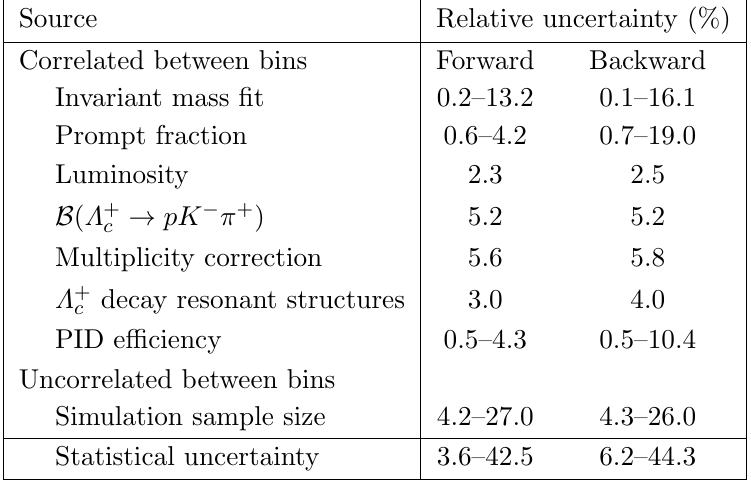
Table 1 . Systematic and statistical uncertainties for the di(cid:11)erential cross-sections. The ranges indicate the variation over the ( p T ; y (cid:3) )